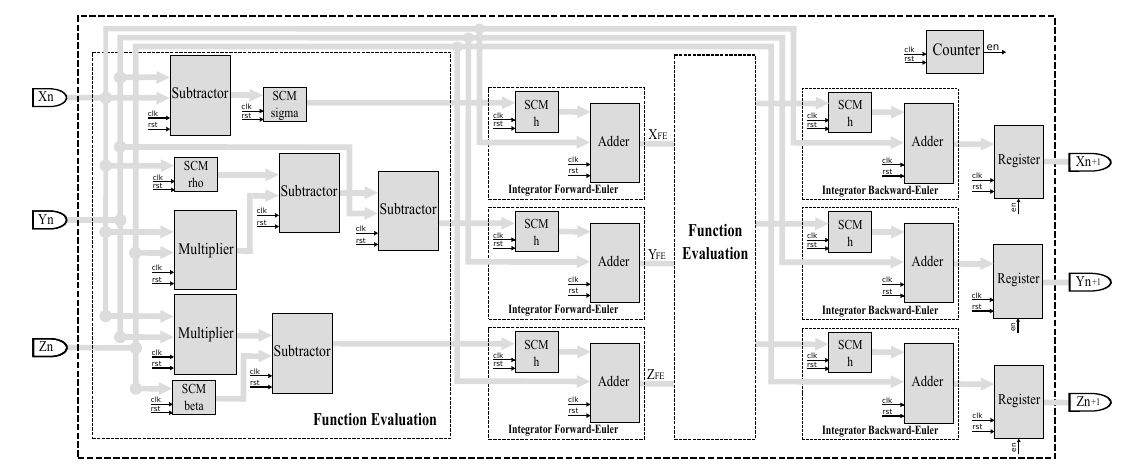
Figure 6. Block diagram description of Equation (5) applying Backward Euler (BE) highlighting function evaluation, integrator Forward Euler and integrator Backward Euler